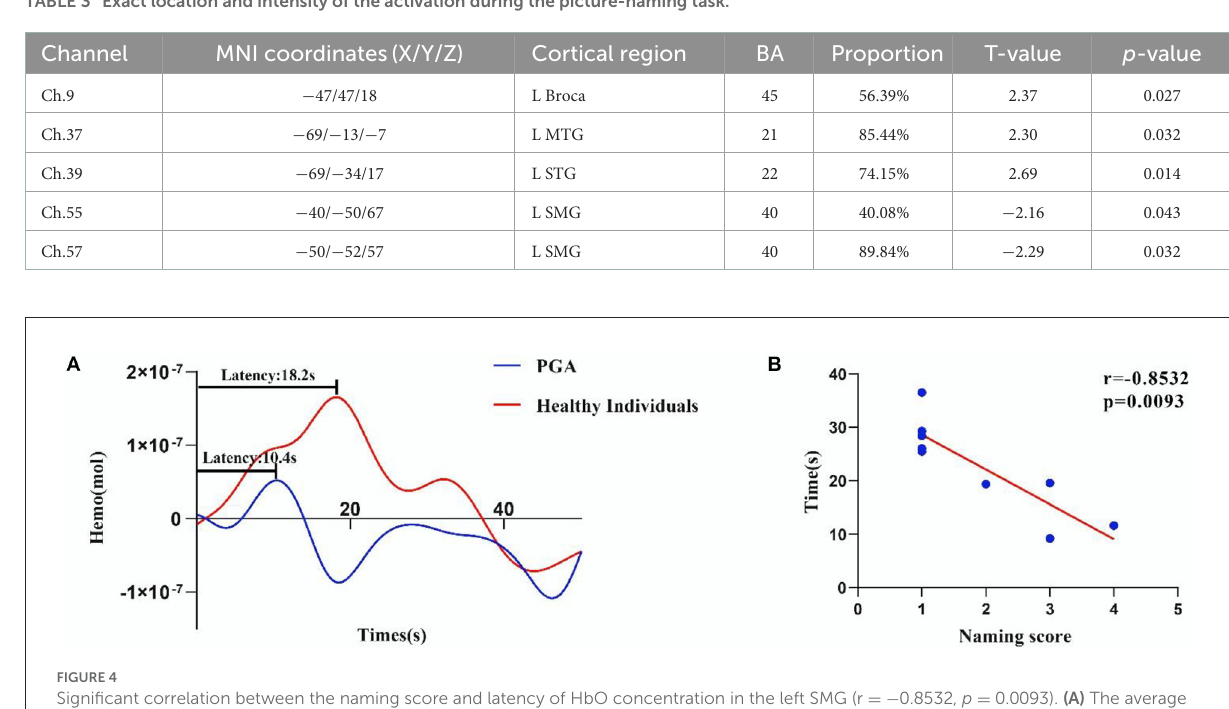
TABLE 3 Exact location and intensity of the activation during the picture-naming task.